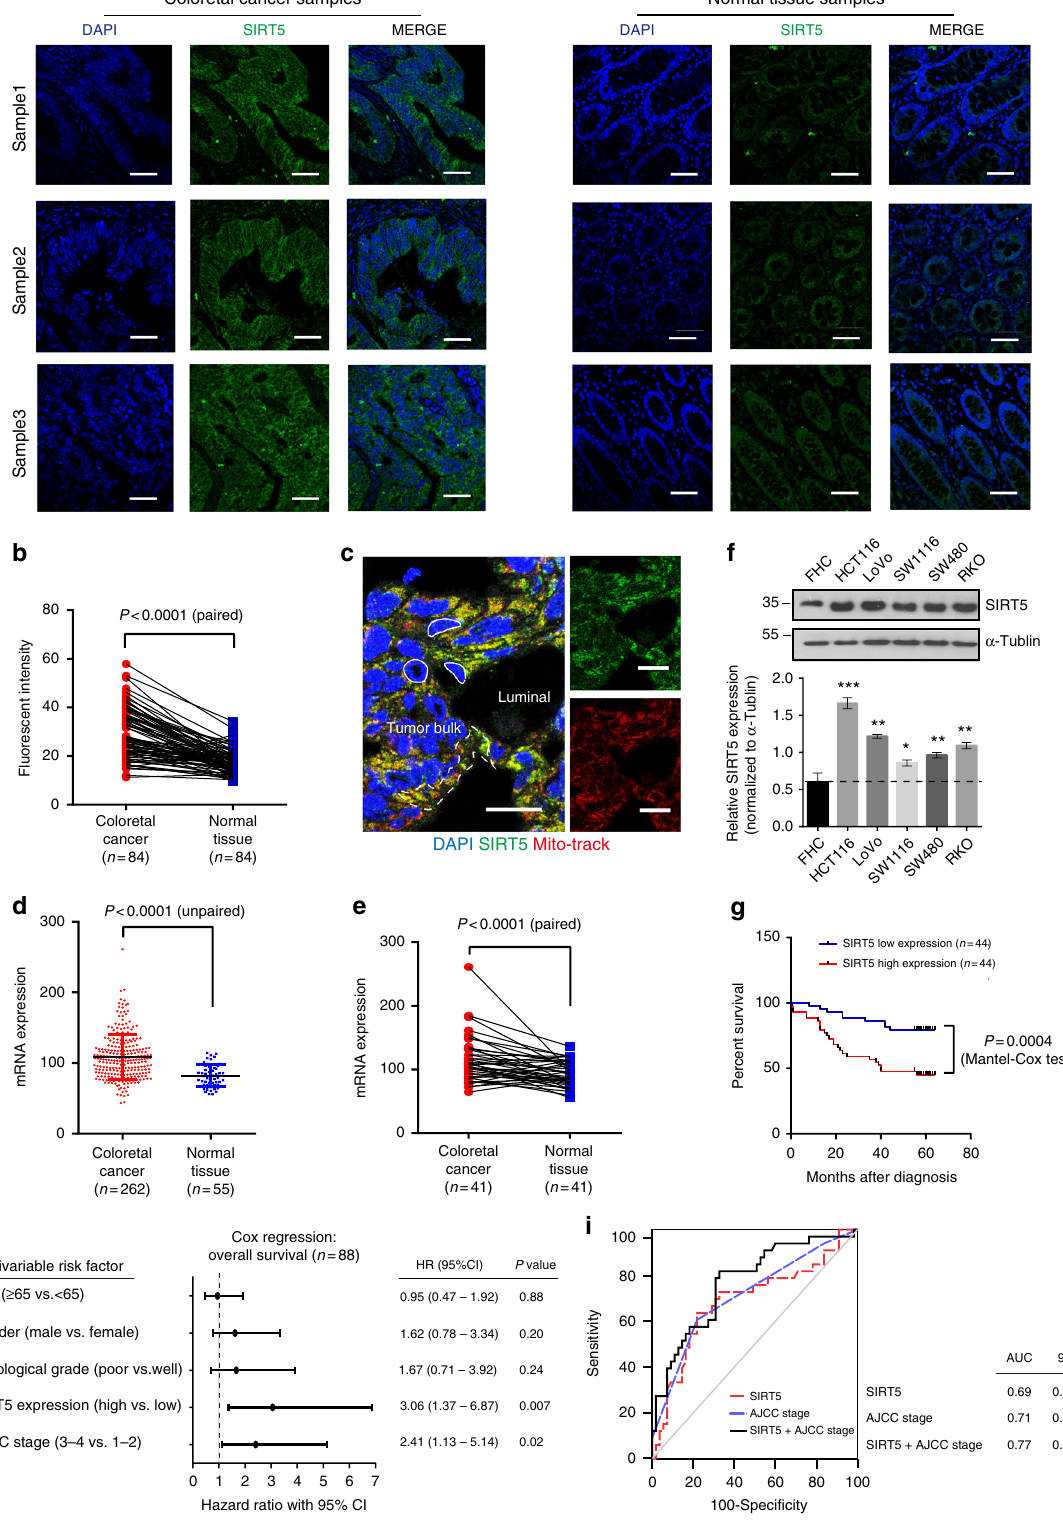
Multivariable risk